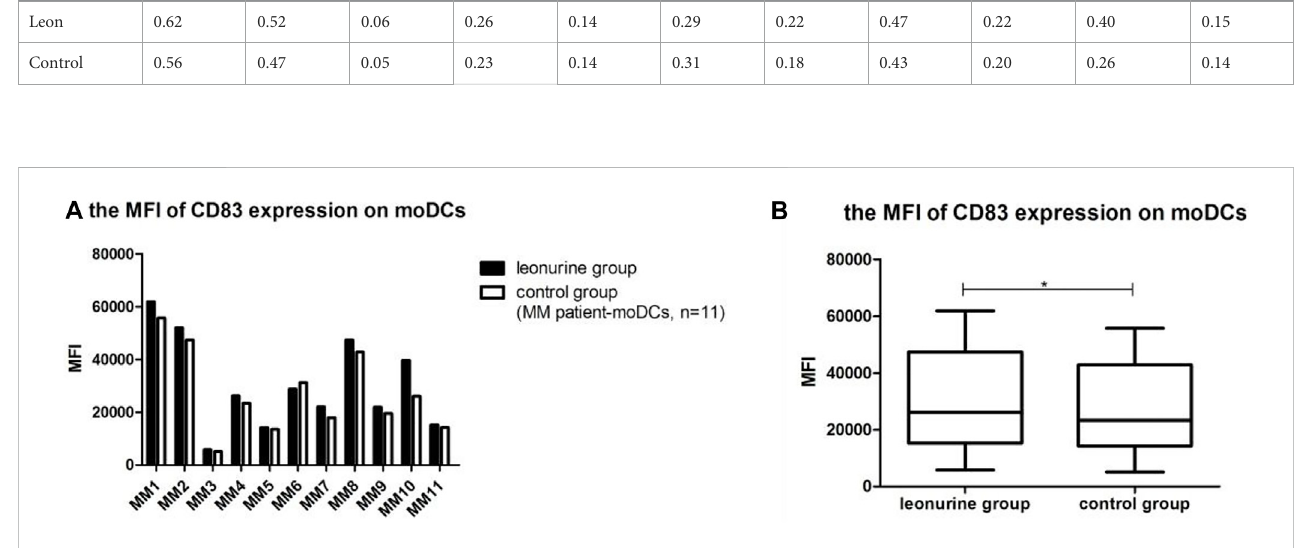
FIGURE 10 TheMFIofCD83expressiononmoDCsbetweentheleonurinegroupandthecontrolgroup(MMpatient-moDCs, n =11). (A) ThegraphshowstheMFIof CD83expression onmoDCs between theleonurinegroupand thecontrolgroup foreach MMpatient. (B) Theboxplotshows that whenmoDCsderived from all 11 MM patients were analyzed together, the MFI of CD83 expression on moDCs was signi fi cantly higher in the leonurine group than in the control group (0.30×10 5 ± 0.18 × 10 5 vs. 0.27 × 10 5 ± 0.16 × 10 5 , p = 0.020, paired-sample t -test).